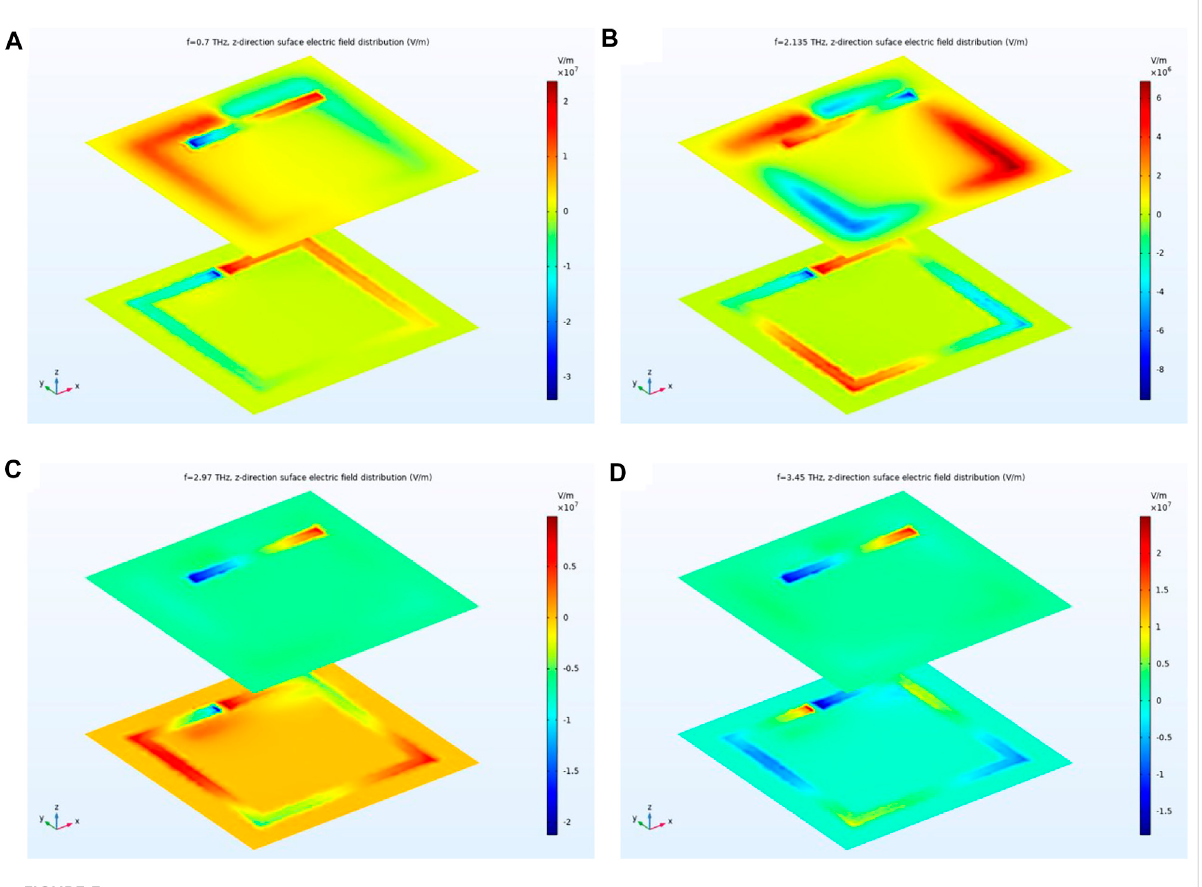
FIGURE 3 The distributions of electric fi eld Ez on the surface of the proposed THz-DS at the four resonant peaks of (A) 0.7 THz, (B) 2.135 THz, (C) 2.97 THz, and (D) 3.45 THz,